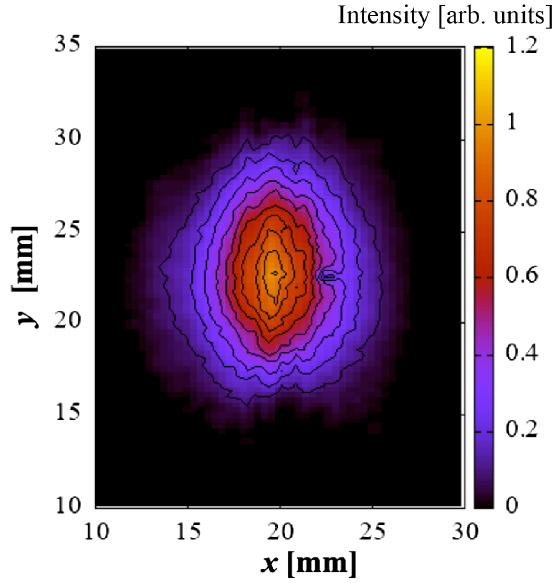
FIG. 15. A two-dimensional mapping of the transverse beam profile of Fig.